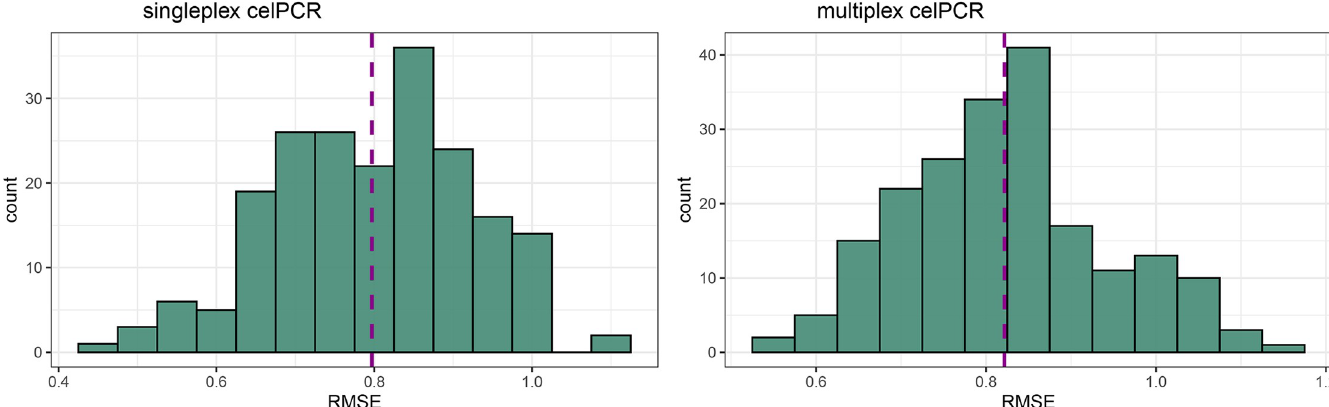
Fig 4. Distribution of Root Mean Square Error (RMSE) for predictions based on singleplex and multiplex celPCR. Histograms of RMSE are derived from 200 random 70:30 splits of the dilution series dataset. Linear mixed-effects models were established for each subset using the 70% share and tested on the respective 30% subset for singleplex celPCR (left column) and multiplex celPCR (right column). Dashed lines indicate mean RMSE (singleplex: 0.80; multiplex: 0.82).